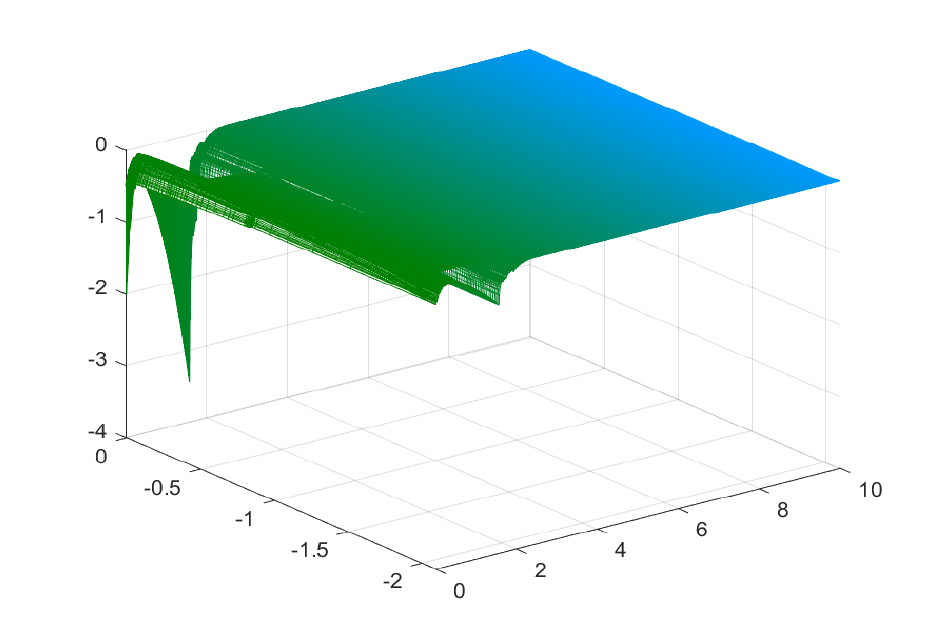
Figure 5. Computer simulation of the solution x ( t ) of the Equation